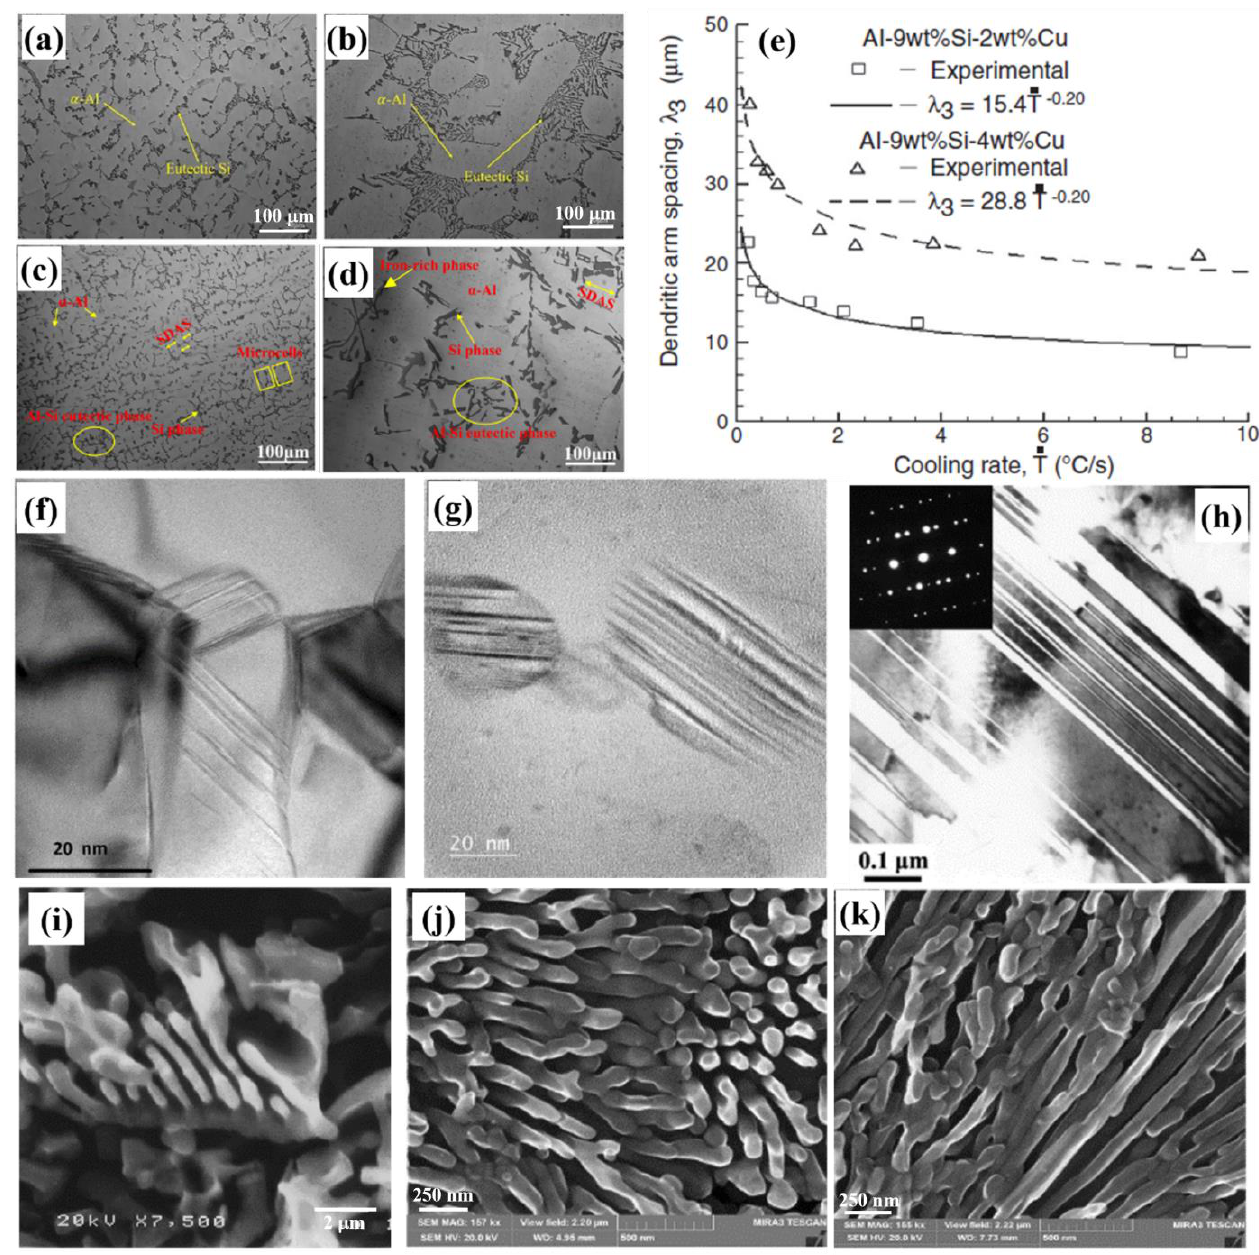
Figure 5. Optical microstructures (OM) of A319 + Sr alloy solidified at a cooling rate of ( a ) 10 °C/s and ( b ) 0.1 °C/s [61]. OM of A319 alloy without Sr solidified at a cooling rate of ( c ) 10 °C/s and ( d ) 0.1 °C/s [62]. ( e ) Change in the tertiary dendritic arm spacing ( λ 3 ) of Al − 9%Si − Cu alloys with cooling rate [182]. Different twin densities observed in eutectic Si particles for ( f ) Al − 20%Si laser − remelted alloy [188], ( g ) Al − 17%Si laser-remelted alloy [188], and ( h ) Al − 11.5%Si − Mg − Cu − Ni + Si 3 N 4 composite [189]. Post − modification morphologies of eutectic Si particles in ( i ) Al − 6%Si − 0.4%Sc alloy [190] and ( j , k ) Al − 20%Si laser-remelted alloy [188]. Reproduced with permission from Elsevier, John Wiley and Sons, MDPI, and Springer Nature.